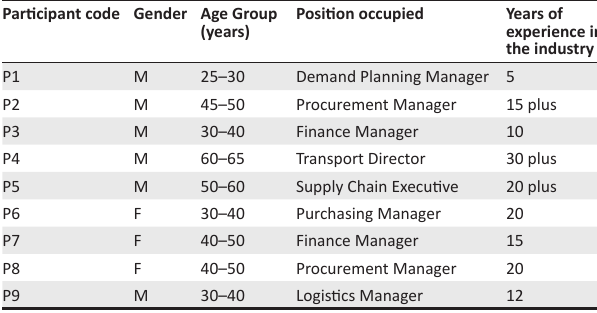
TABLE 1: Demographic profile of participants. Participant code Gender Age Group